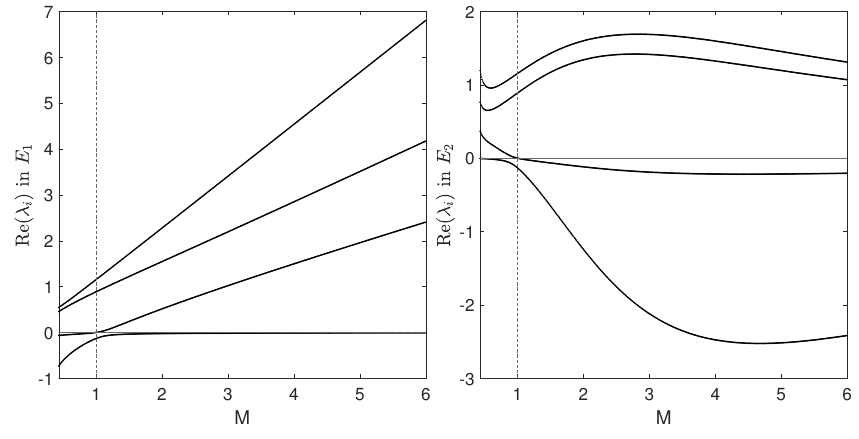
Figure 7. Eigenvalues of the Jacobian J | E increased with respect to the reference case: δ = 4, θ = 0.05, ν = 0.5 (corresponding to Pr =